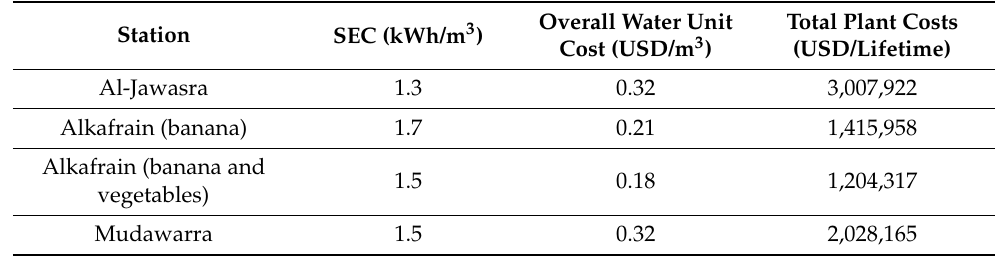
Table 6. Economic Feasibility of PV-BWRO desalination for the Agricultural, Domestic, and Industrial